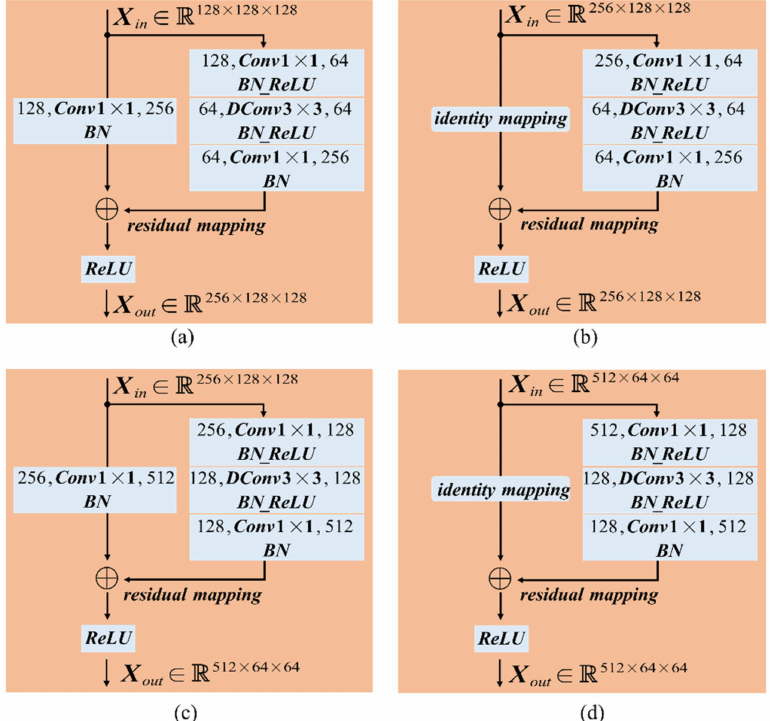
Figure 2. Architecture of the bottleneck residual blocks. Convolution layers are denoted by “number of kernels of each filter, kernel size, number of filters”, e.g., “128, Conv1 × 1, 64”. Conv and DConv indicate the 2-D convolution layer and deformable convolution layer, respectively. ( a ) Structure of Layer1_1. ( b ) Structure of Layer1_2 and Layer1_3. ( c ) Structure of Layer2_1. ( d ) Structure of Layer2_2, Layer2_3, and